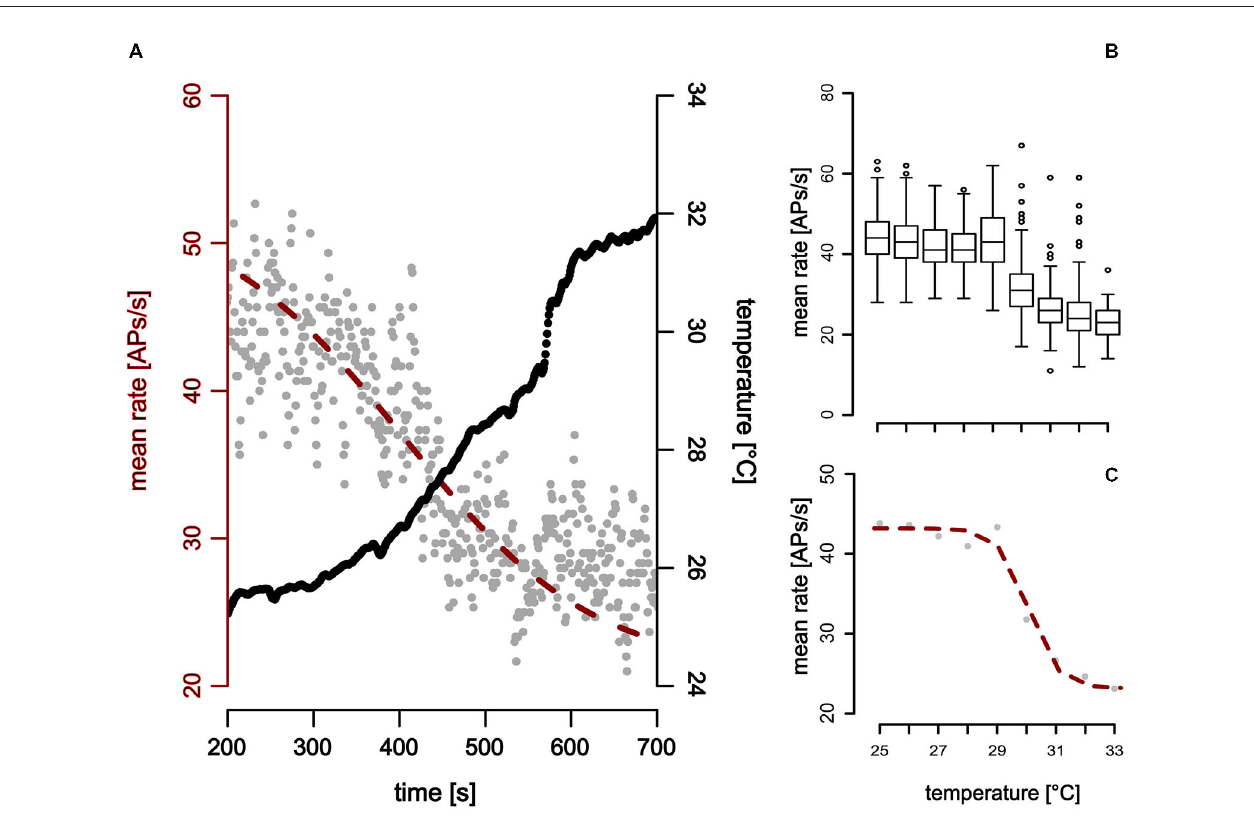
does not change when temperature was increased further (Note that this is the case even at sudden temperature changes, e.g., around 600 s in (A) . (A,C) A sigmoidal fit describes the activity of the neuron during temperature increase